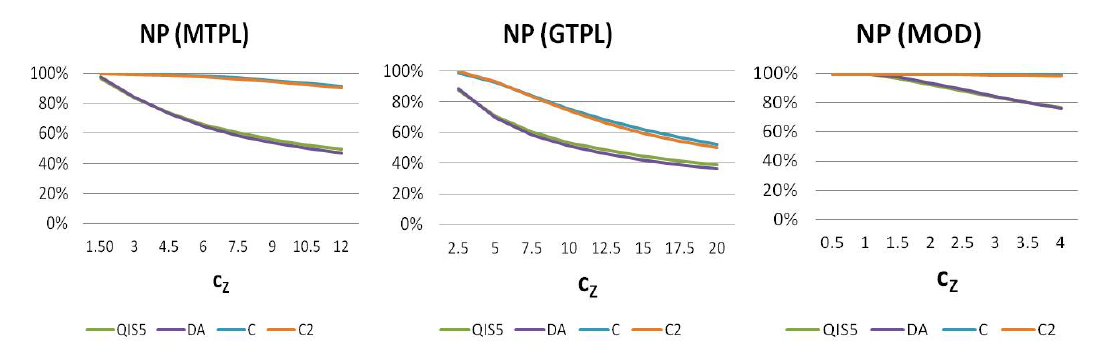
Figure 3. NP LoB according to several coefficients of variation of claim size ( c z